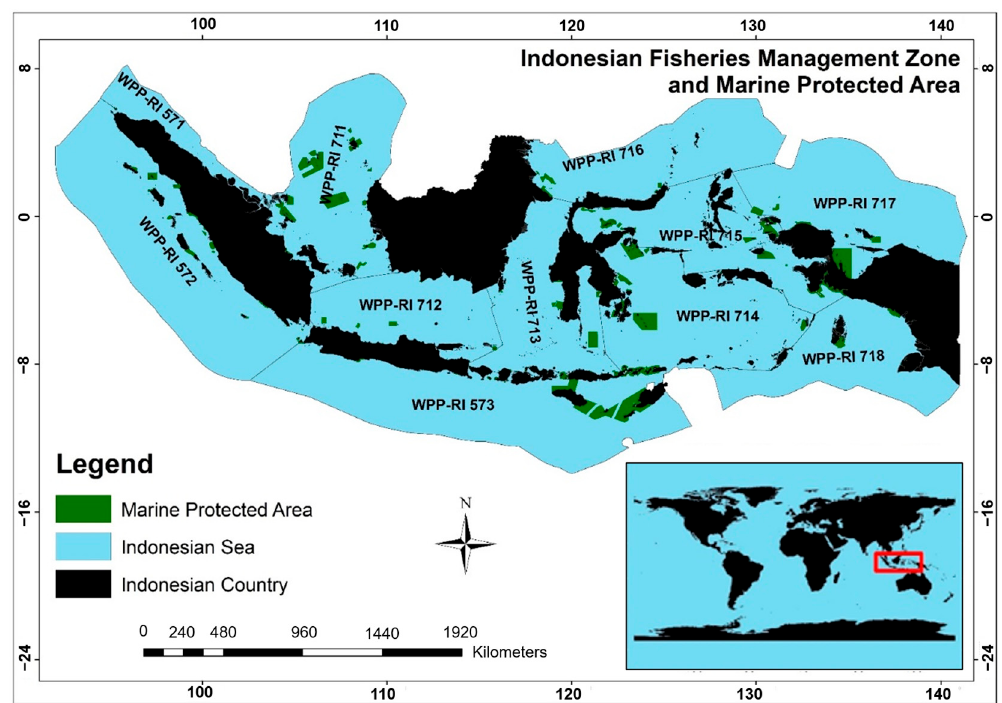
Figure 1. Map presenting the Indonesian Fisheries Management Zone (IFMZ) and Indonesian marine protected areas (MPAs).